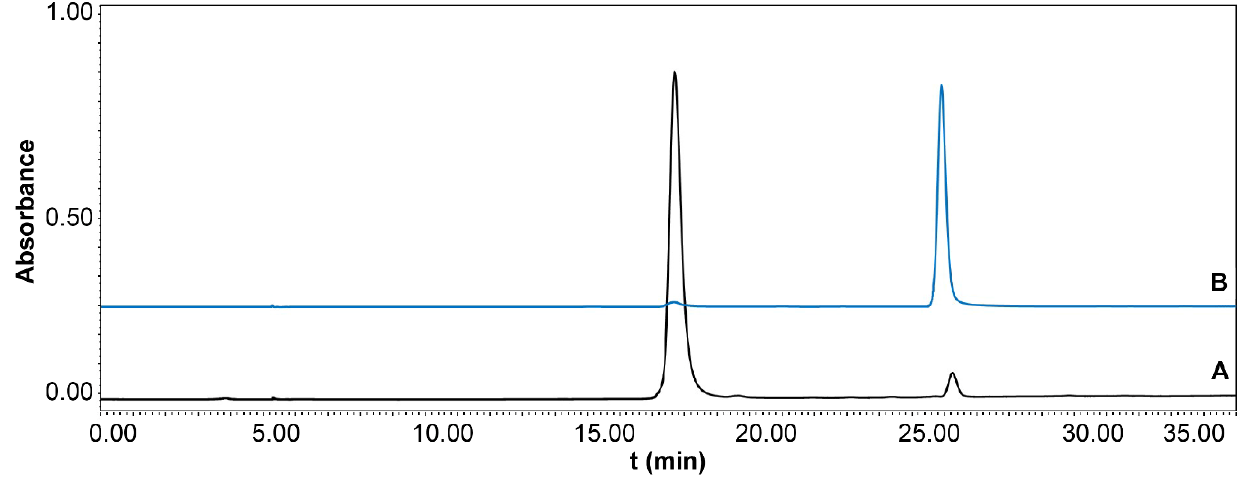
Figure 6. High-performance liquid chromatography chromatograms of compounds 1 and 2. (A) Compound 1, identified as betulin; (B) Compound 2, identified as lanosterol.